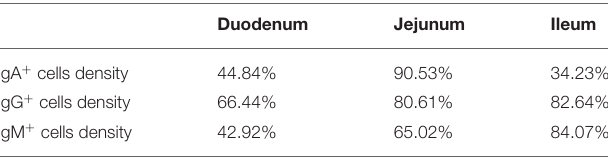
TABLE 1 | Decrease rate of IgA + , IgG + , and IgM + cells in the small intestine of sheep infected with Moniezia benedeni (%).